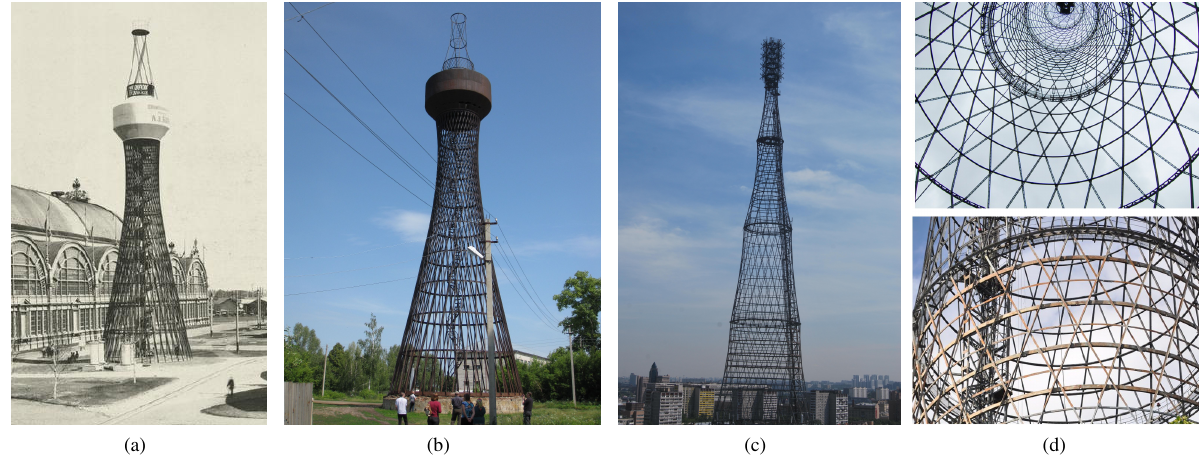
Figure 1. The world’s first diagrid hyperboloid water tower (37 m height) built by V. Shukhov for the All-Russian Exposition in 1896 in Nizhny Novgorod, Russia (a), now located in Polybino (b). The Shukhov radio tower, also known as the Shabolovka tower, build between 1919 and 1922 in Moscow, Russia (c) and some details of the wire hyperboloid structure